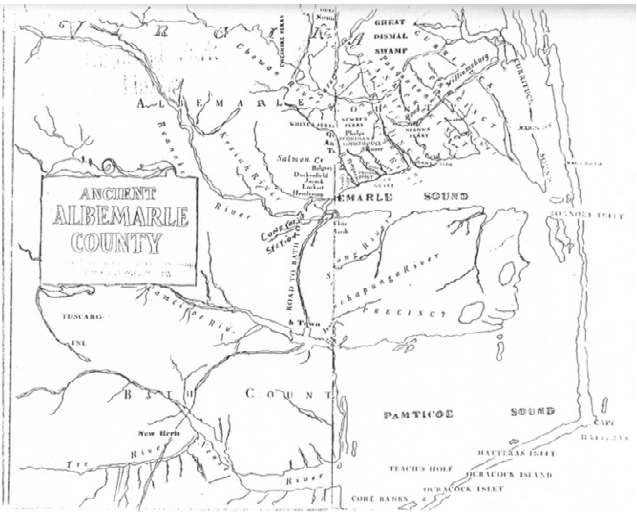
Figure 7. Map of colonial coastal northeastern Carolina where George Foster Pierce’s European ancestors settled. Map from (Pierce et al. 1980, p. 10).